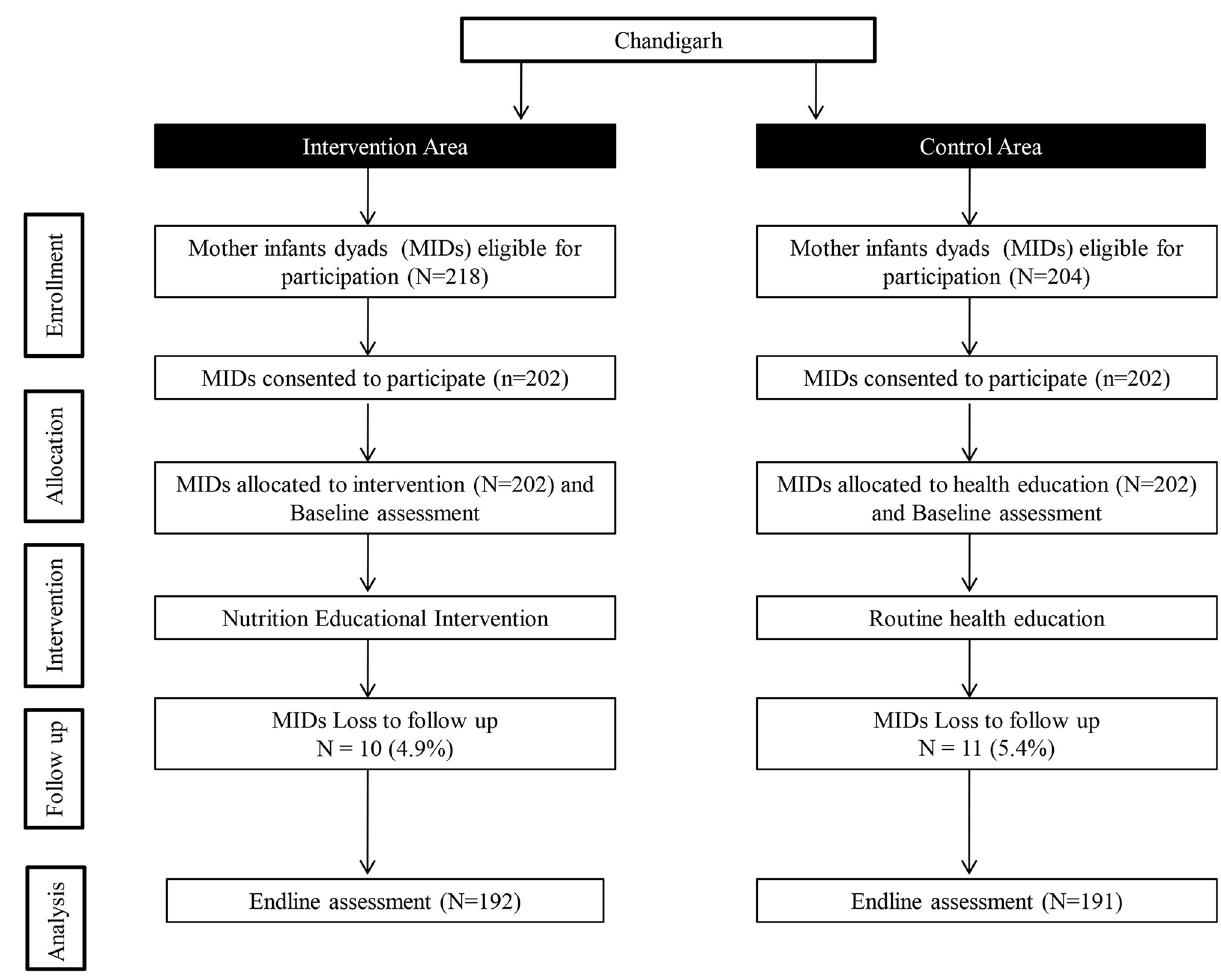
Fig 1. Flow chart showing the study